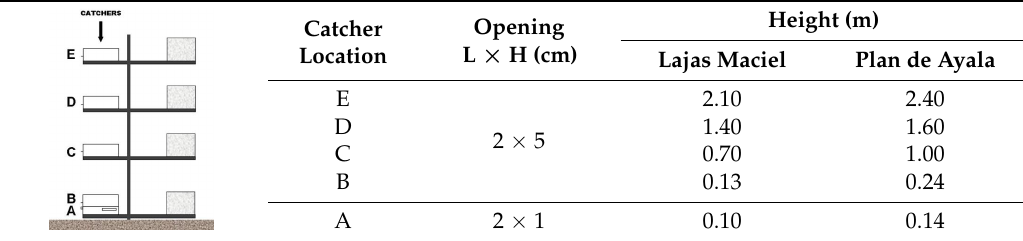
Table 2. Soil parameters and characteristics from the study sites.